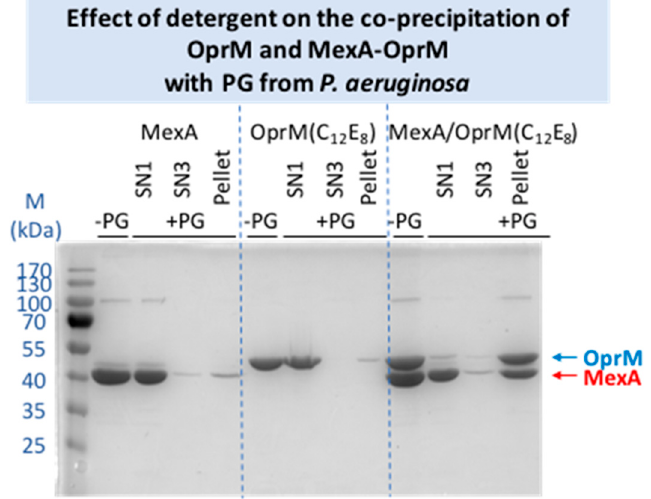
Figure 3. Pull-down experiments performed with the PG extracted from P. aeruginosa and with the MexA and OprM proteins after exchange of the DDM detergent for the C 12 E 8 . The same labeling as for Figure 2 have been used.